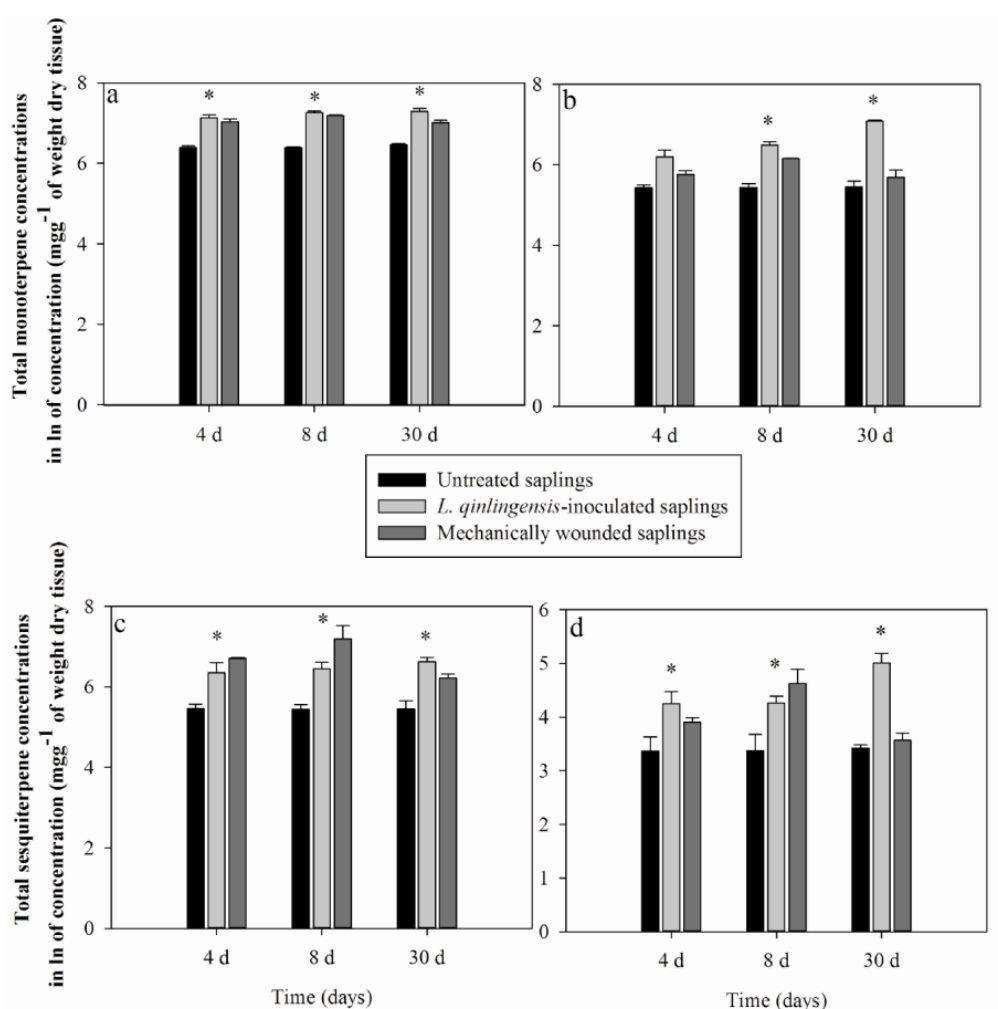
Figure 1. The total monoterpene and sesquiterpene concentrations (μg·g −1 of dry weight tissue) in the phloem and xylem of the stem of P. armandi saplings differ among treatments at each time point. Date were transformed (ln) for analysis; a , c = phloem; b , d = xylem; * indicates that there was a significant difference ( p < 0.05) among treatments using ANOVA at each time point. Each bar represents the mean total ± standard error of three